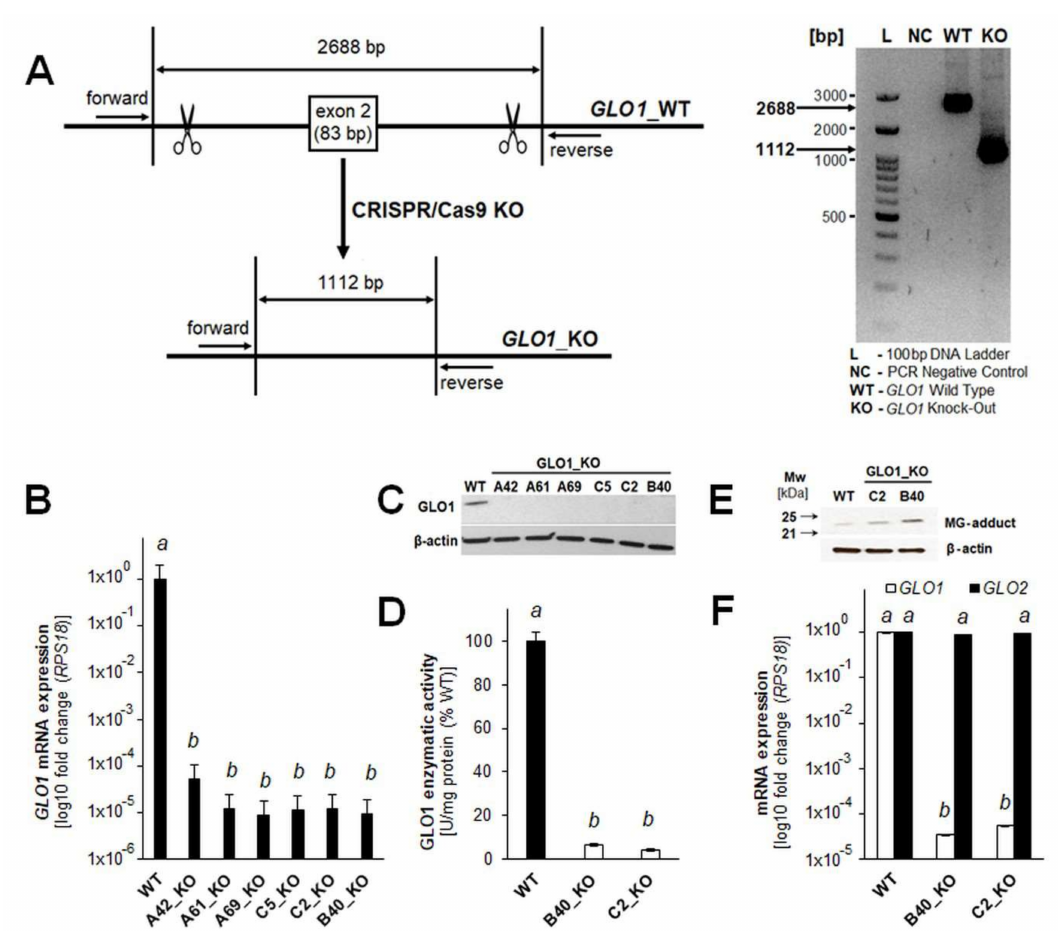
Figure 1. Genomic deletion of GLO1 in A375 human malignant melanoma cells. ( A ) Exon